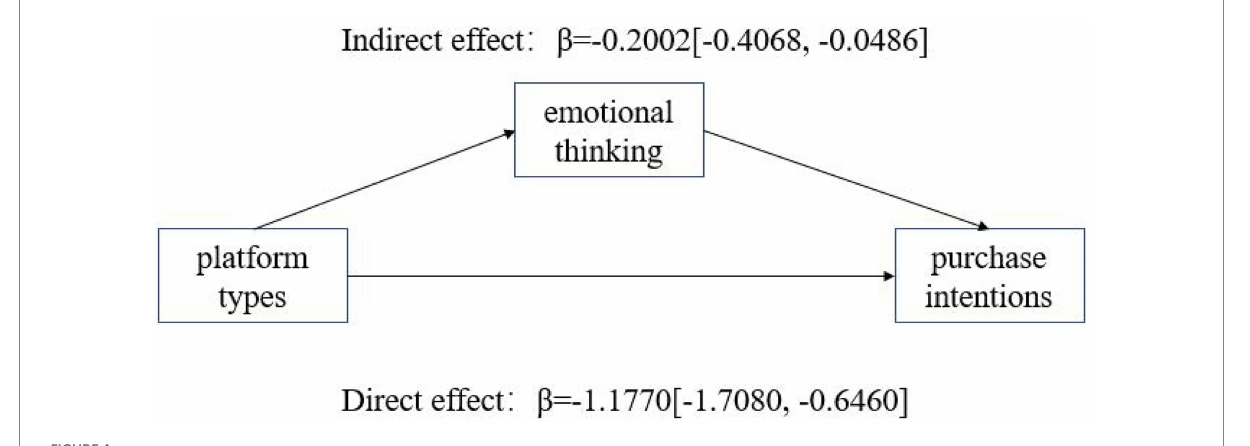
FIGURE 4 Mediated test of emotional thinking (recreational